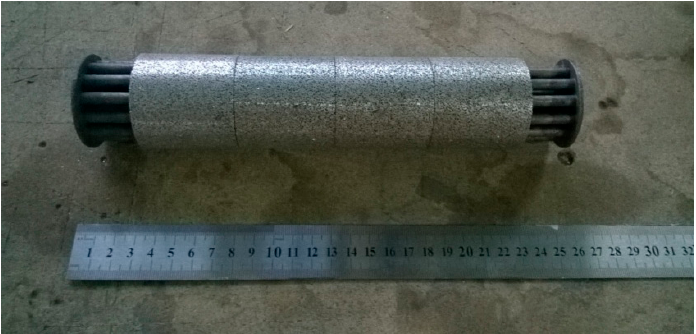
Figure 2. The inner part of the heat exchanger made of aluminum with porous filling.